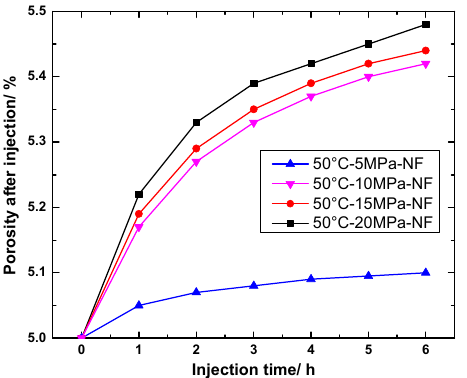
Figure 10. Variation in porosity with time for NF specimens under different pressures.